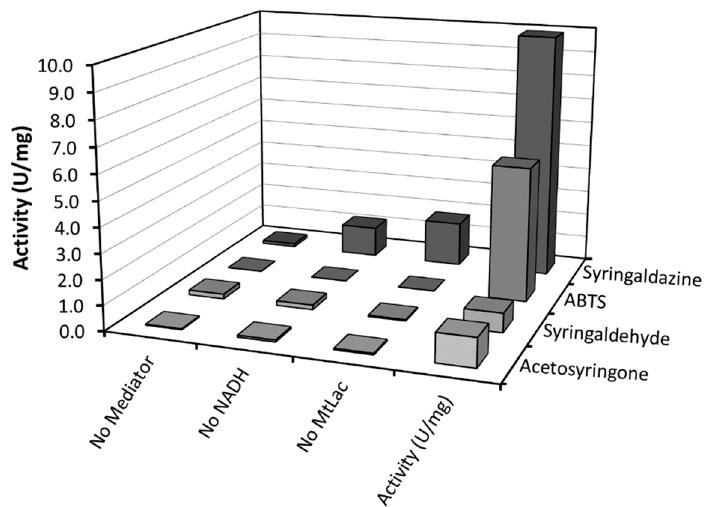
Figure 3. Activity of Mt Lac in presence of 5 μM of different mediators, 0.5 mM NADH and 100 mM KPi buffer (pH 8.0) at 25 °C. The background activities of the controls in absence of NADH, mediator and laccases are reported.